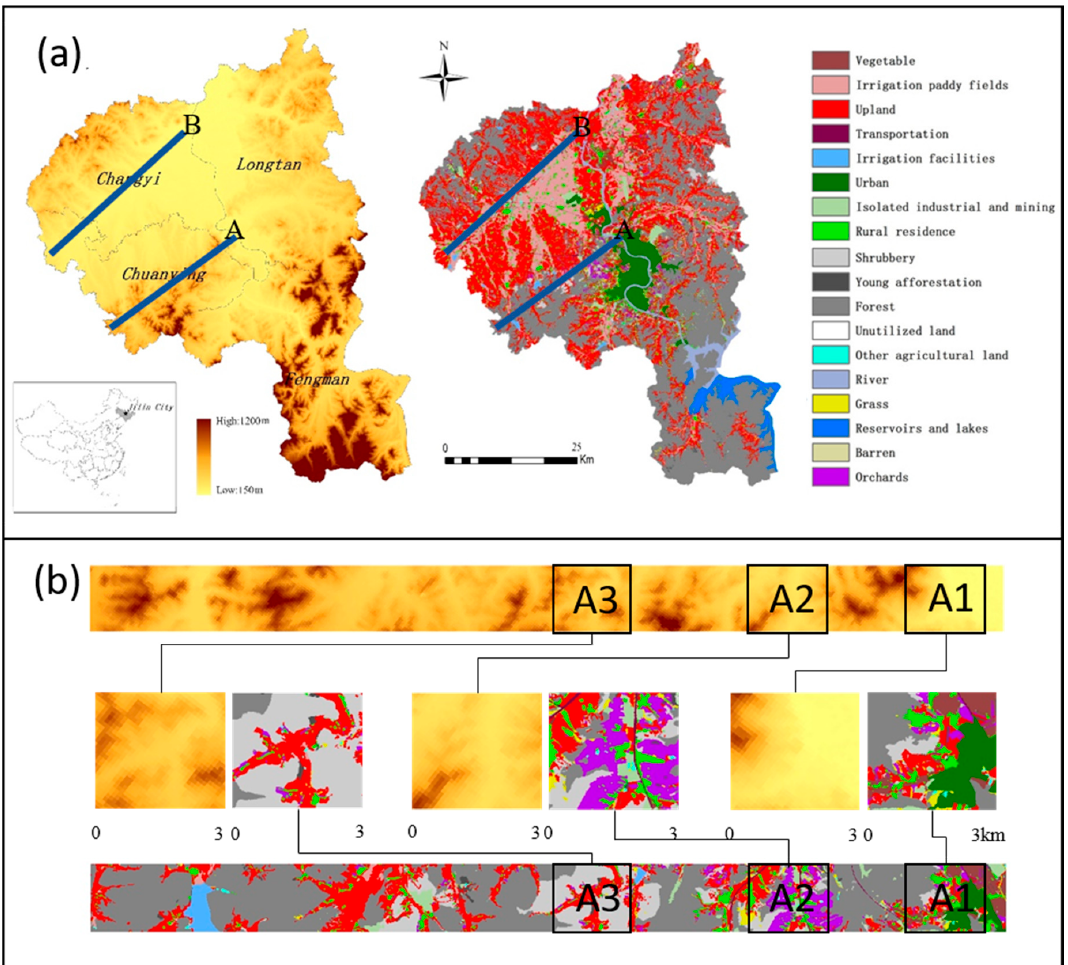
Figure 1. The digital elevation model (DEM) and landscape of Jilin City and the locations of landscape profiles A and B ( a ). The correlations between landscape and topography at specific locations A1, A2, and A3 within profile A are shown in ( b ). A1 is located in the north of the downtown area and includes more diverse land use types in its northern part. A2 has two major roads across the valley, and the land use types are distributed symmetrically along the traffic lines. A3 represents the mountain area, and the number of landscape patches is less than in the other samples. The area is located approximately 15 km from the downtown area.